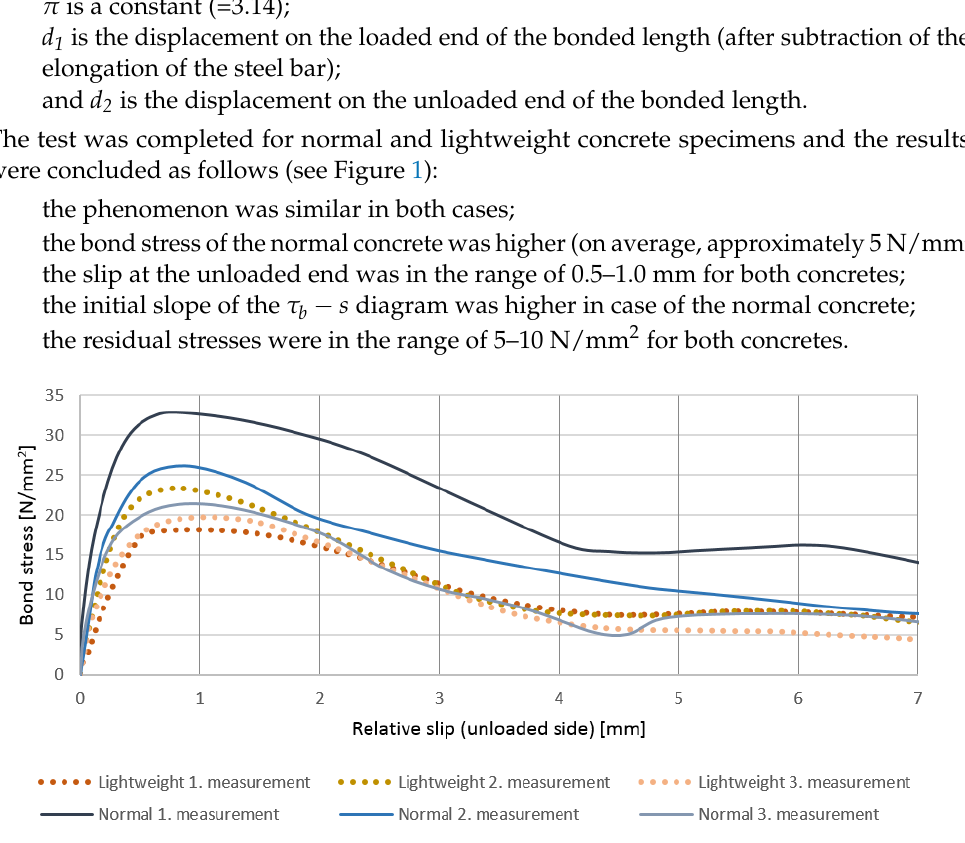
Figure 1. Bond stress–slip diagram of normal and lightweight